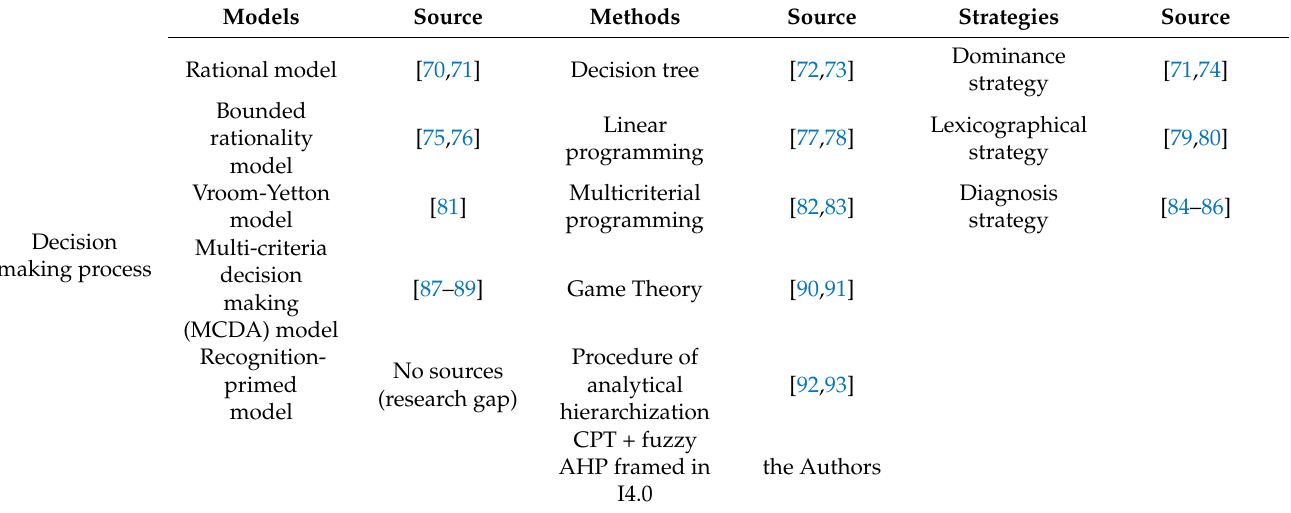
Table 2. Literature analysis—models, methods and strategies in decision-making